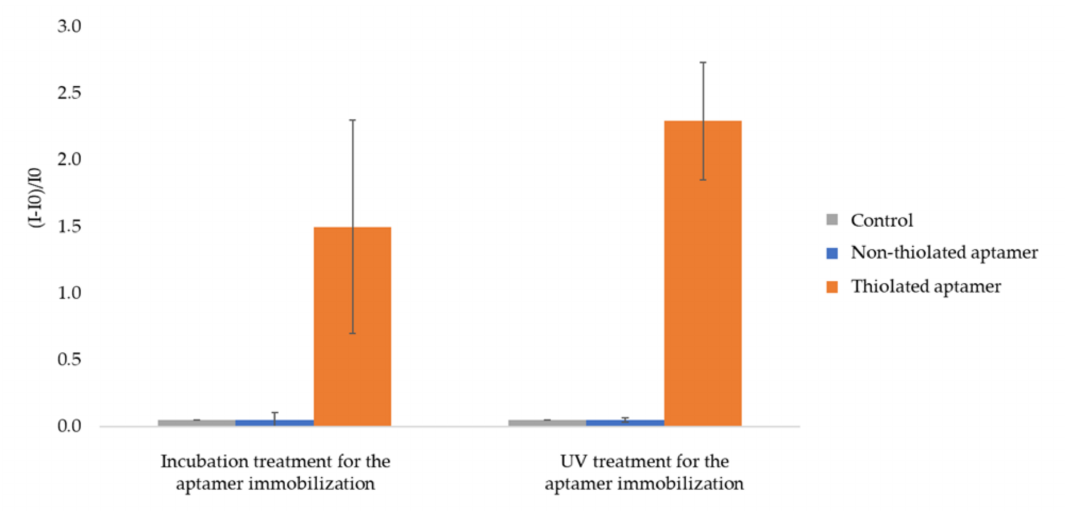
Figure 4. Relative fluorescence intensity of AuNPs 1-coated 2.5 thiol plates functionalized by fluorescent aptamer. I0 is the fluorescence intensity of AuNPs-1-coated 2.5 thiol substrate. I is the intensity of fluorescence measured after functionalization by aptamers and rinsing (See experimental section for more details on experimental conditions and fluorescence measurement parameters). The error bars represent the standard deviation for 3